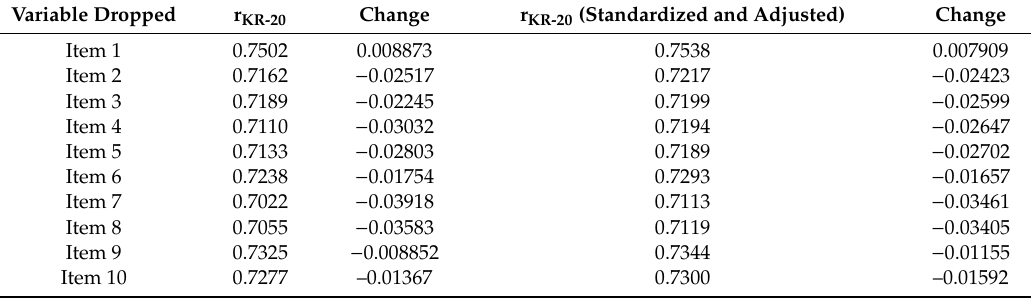
Table 2. Reliability statistics of the second part of the questionnaire according to the Kuder–Richardson Formula 20